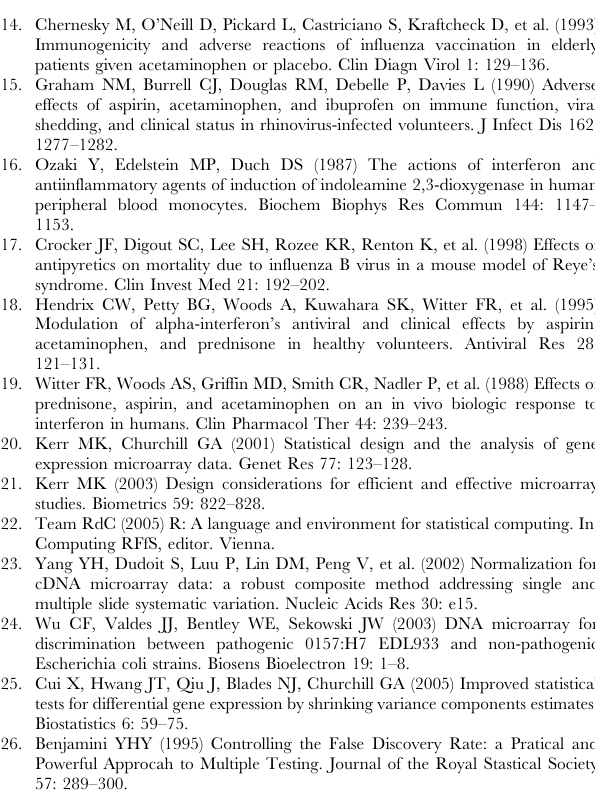
Table S2 A. = APAP, I. = IFN- b , V. = Vehicle, I.A. =IFN- b + APAP. Comp. = Comparison, Reg. = Regulation and ‘ + ’ indicates up-regulated and ‘ 2 ’ indicates down-regulated, Gen- es= Genes Enriched/Total Genes in Set, NES= Normalized Enrichment Score, FDR= False Discovery